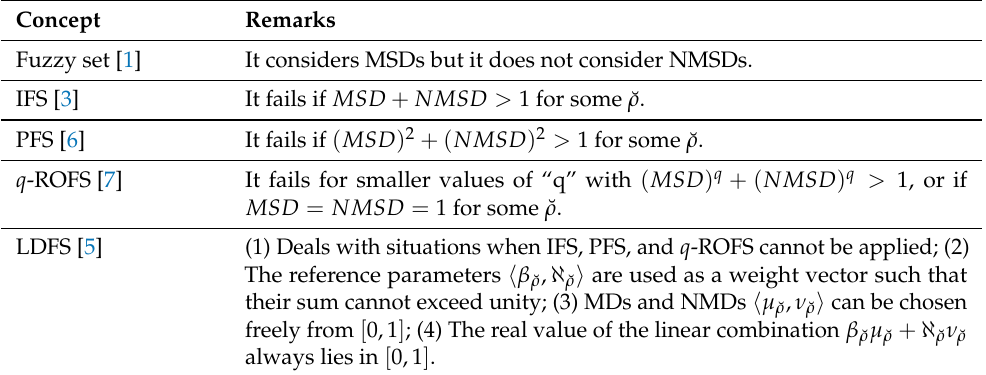
Table 1. Comparison of LDFS with some existing fuzzy